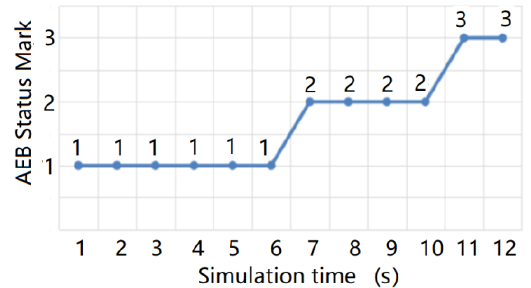
Figure 27. AEB state change without radar environmental clutter simulation data.